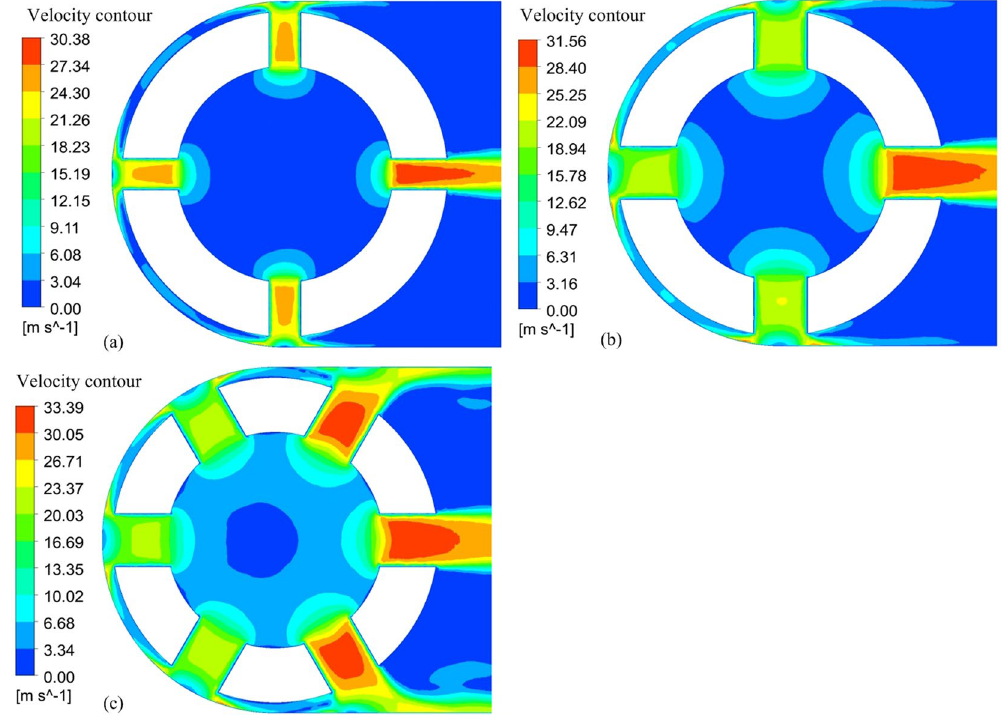
Figure 3. Velocity distributions at section A for a flat-ended tool tube: ( a ) four outlet holes of diameter 0.6 mm; ( b ) four outlet holes of diameter 1 mm; ( c ) six outlet holes of diameter 1